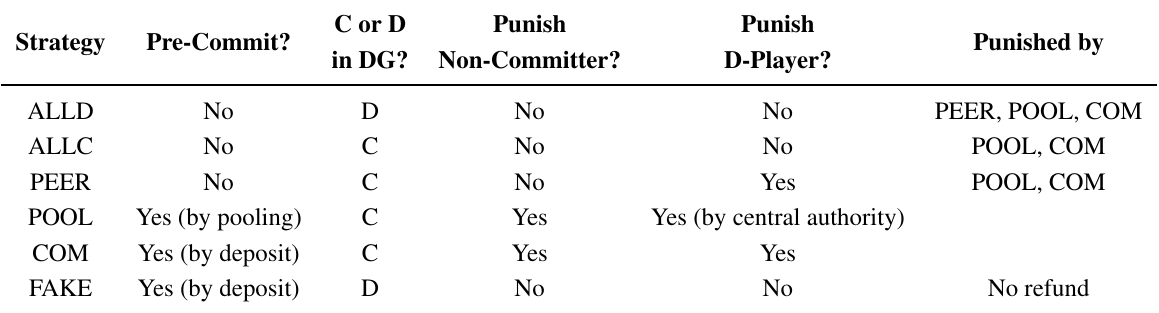
Table 1. Decisions and reactions of strategies. Non-committers (ALLD, ALLC and PEER) are punished by POOL and COM. D-players (ALLD and FAKE) are punished by PEER, POOL and COM. Fake committers (FAKE) are sanctioned by means of no